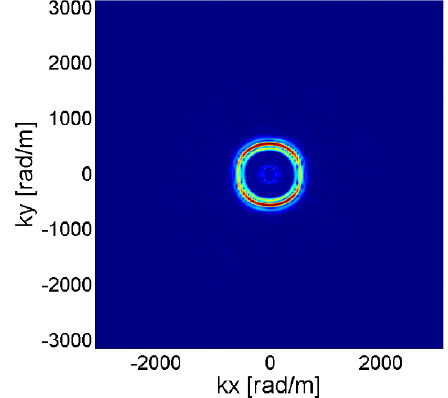
Figure 3. Averaged wavefield image in the wavenumber-wavenumber domain.